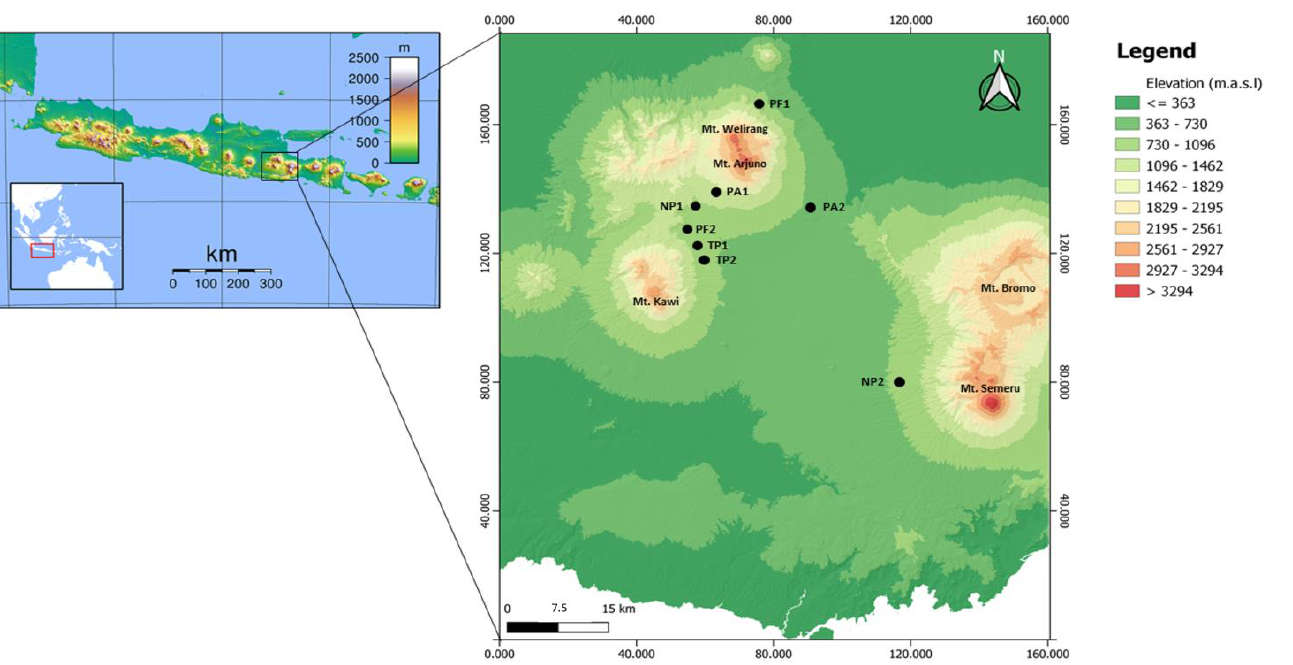
Figure 1. Distribution of collection sites for the ambrosia beetles in the pine forest types, East Java, Indonesia. PA = pine forest-based agroforestry, NP = non-tapped pine forest, PF = protected pine forest, TP = tapped-pine forest.